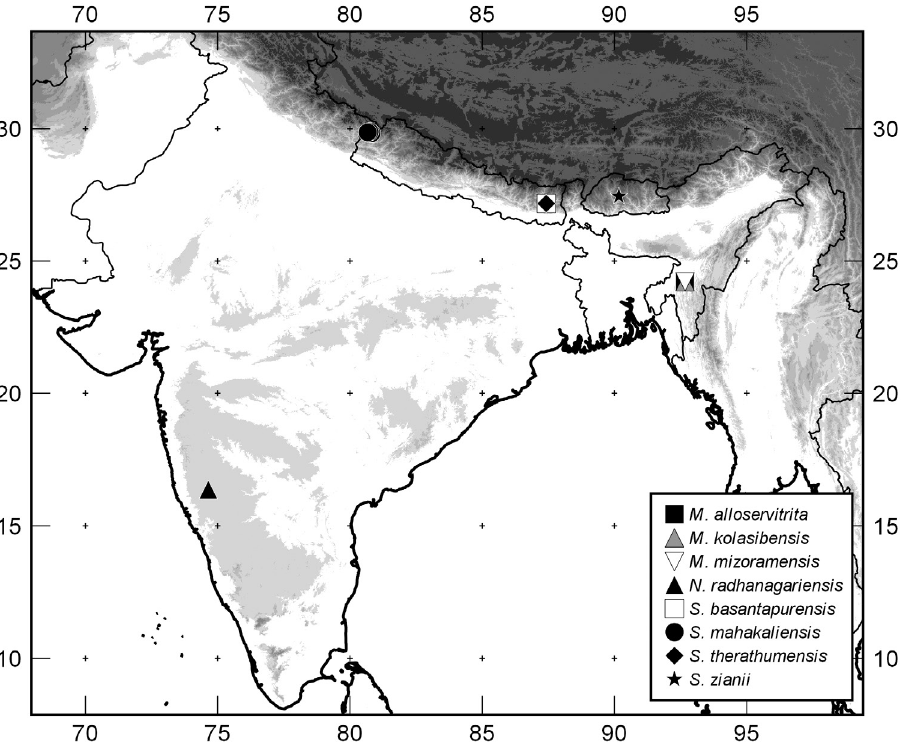
Figure 5. Distributions of the new taxa described in this